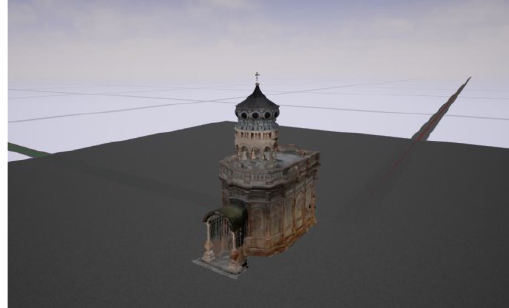
Figure 7. The final placement of the 3D model inside the